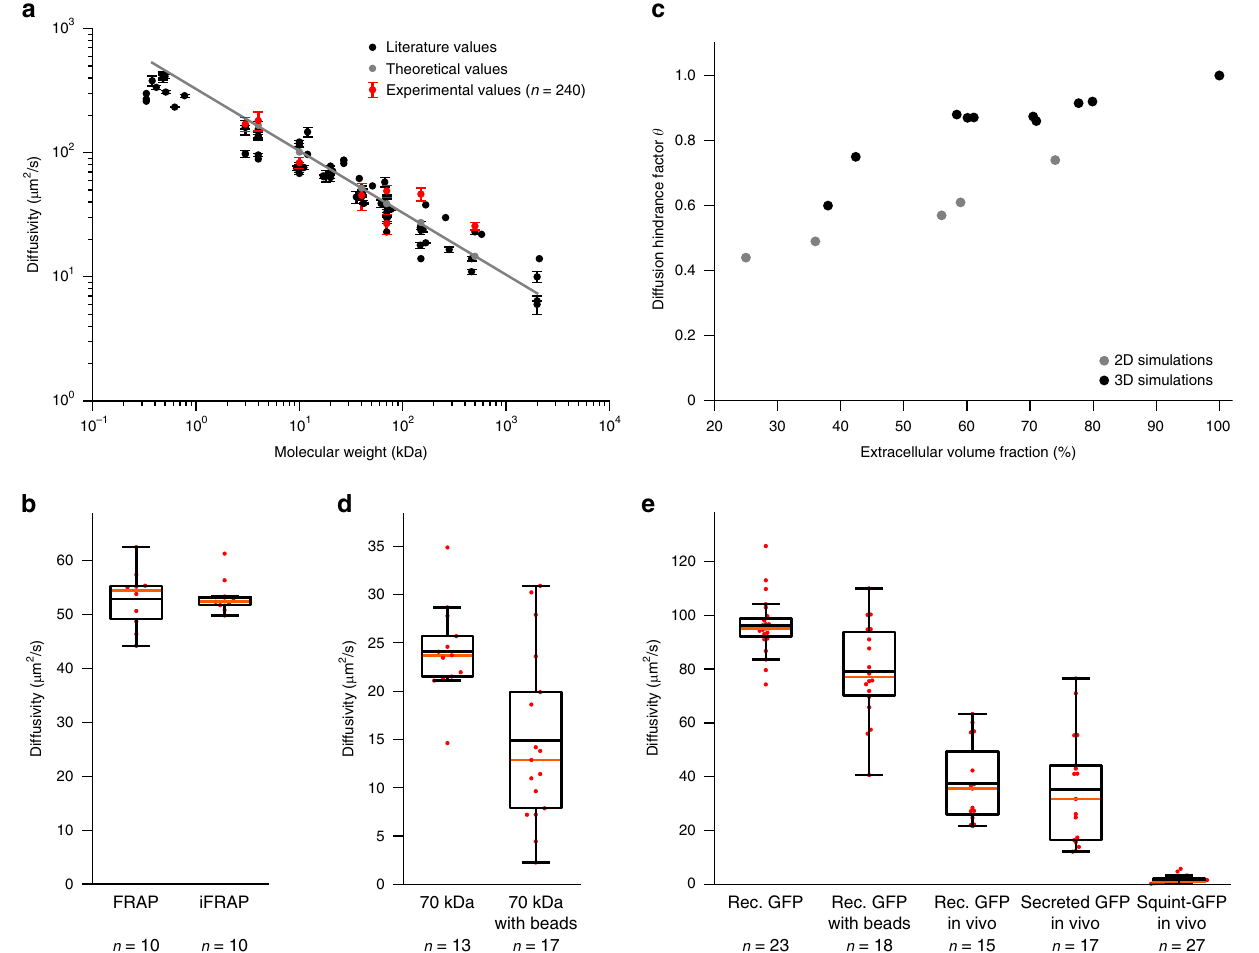
Fig. 5 Effective diffusion coef fi cients determined by PyFRAP. a Results of in vitro experiments and PyFRAP analysis for freely diffusing fl uorescent dextrans of different molecular weights. Black markers indicate literature values for fl uorescent dextrans, red markers the mean effective diffusion estimates obtained by in vitro experiments and PyFRAP analysis, and grey markers the theoretical estimates derived from the Einstein-Stokes equation (see Supplementary Note 3). Red error bars show the standard deviation of PyFRAP ’ s effective diffusion estimates, and black error bars show the standard deviation of the literature values listed in Supplementary Table 7. The grey line represents a linear regression fi t to the theoretical values. b Results of FRAP/iFRAP experiments for the photoconvertible protein Dendra2. c Results of simulations investigating the in fl uence of tortuosity on effective diffusion for differently packed bead experiments. Grey and black markers indicate 2D and 3D simulation results, respectively. d Results of fl uorescent dextran experiments demonstrating the impact of tortuosity on effective diffusivities. e Results of GFP experiments to analyse the impact of tortuosity, embryonic extracelluar environment, protein production, and extracellular binding on effective diffusion estimates. Box plots in b , d , e show median (orange line), mean (black horizontal line inside box), 25% quantiles (box), and all included data points (red markers). Whiskers extend to the smallest data point within the 1.5 interquartile range of the lower quartile, and to the largest data point within the 1.5 interquartile range of the upper